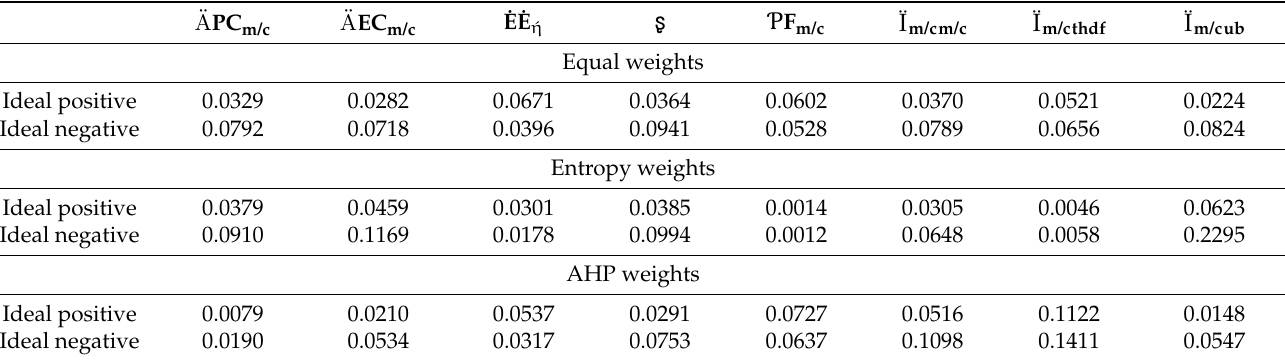
Table A5. Ideal positive and negative results.